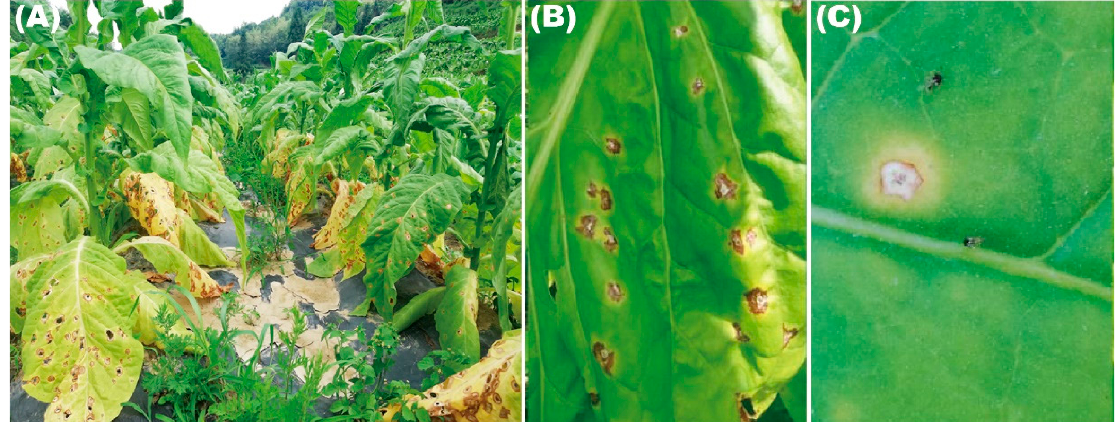
Figure 1. ( A – C ) Diseased tobacco leaf symptoms in the field.